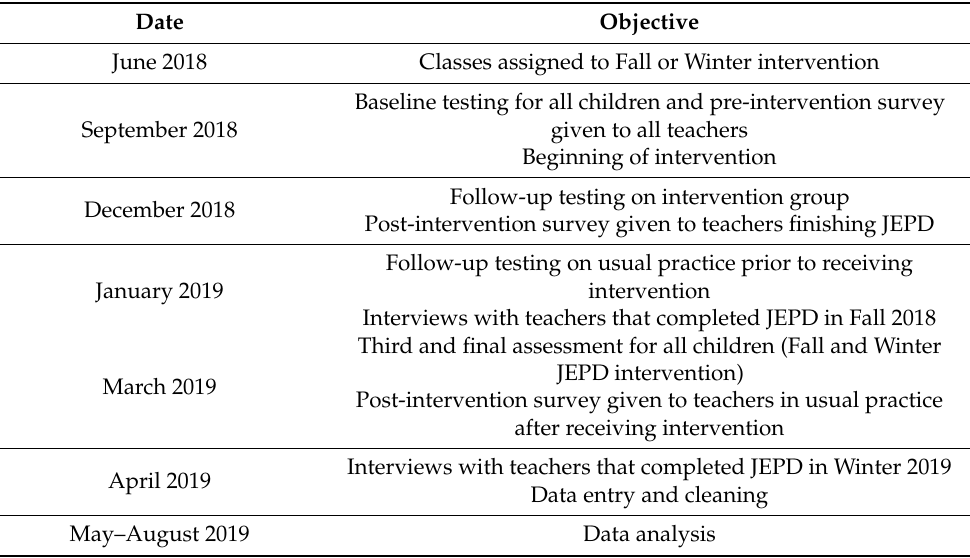
Table 3. Timeline of study from assignment of classes to data